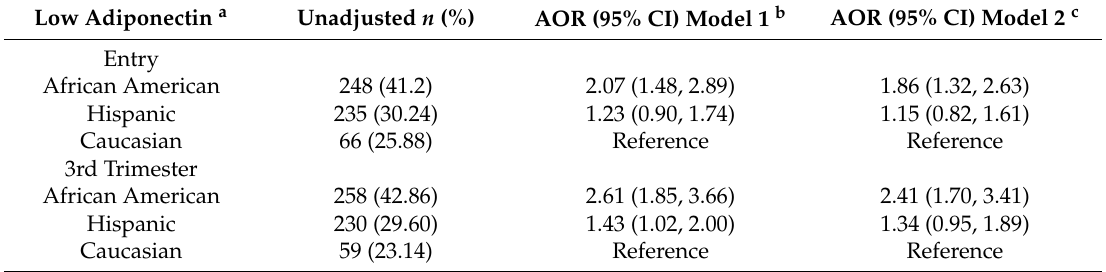
Table 3. Multiple logistic regression analysis for the associations of decreased adiponectin with ethnicity. Low Adiponectin a